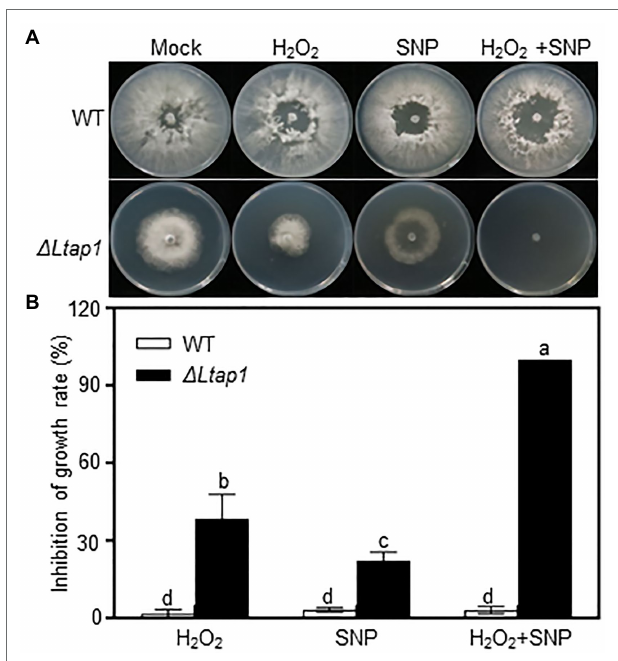
FIGURE 4 | Involvement of LtAP1 of L. theobromae in response to nitro- oxidative stress. (A) Fungal growth of WT and the deletion mutant strain Δ Ltap1 cultured on PDA stressed with 1 mm H 2 O 2 and/or 5 mm Sodium nitroferricyanide dihydrate (SNP), or water (mock) at the indicated concentration after 36 h. (B) Inhibition rate of fungal growth on PDA with stress treatment in relation to the mock. Values are means ± SD of three biological replicates. Different letters on top of paired bars represent a statistically significant difference at p < 0.05.